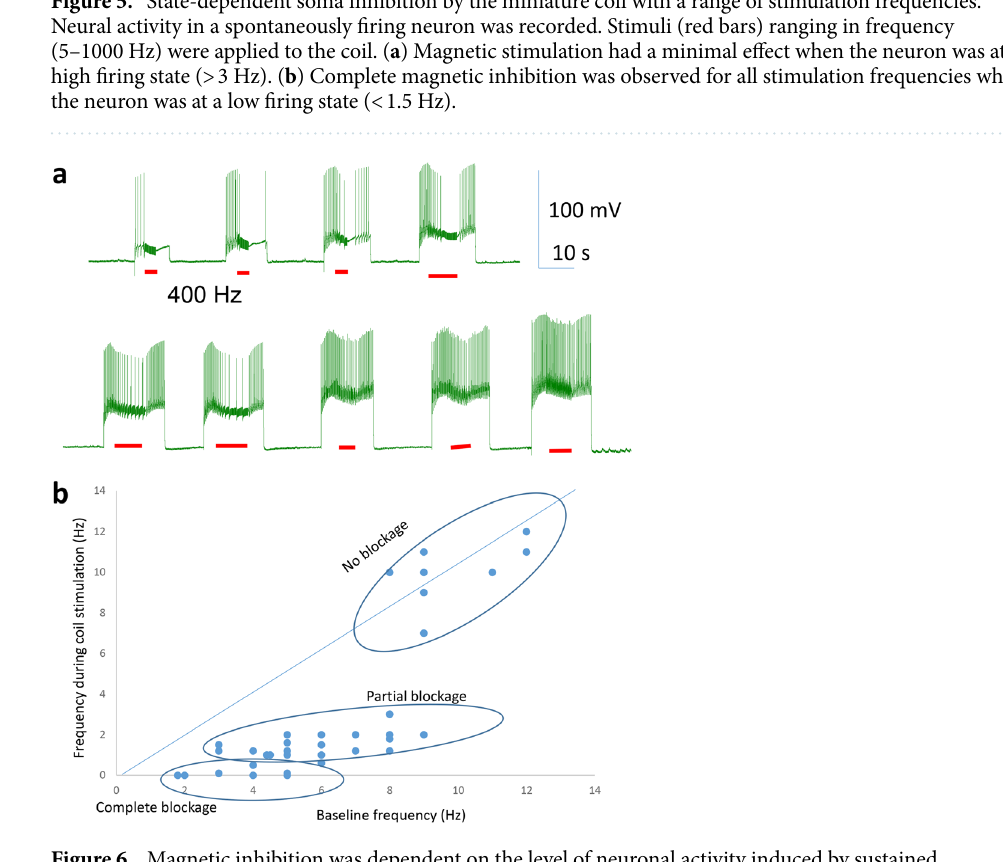
Figure 6. Magnetic inhibition was dependent on the level of neuronal activity induced by sustained depolarization current. ( a ) Depolarization currents with gradual increases in intensity (starting from 1 to 9 nA, with 1 nA increments) were injected into the neuron (resting potential − 55 mV) to elicit action potentials. Magnetic stimulation (400 Hz, red bars) was applied to the soma for inhibition. When firing with low frequency, the neuron was completely inhibited by the miniature coil. When firing at a high frequency, the neuron sustained its activity during magnetic stimulation. ( b ) Firing frequency of the neuron in baseline recording versus that during magnetic